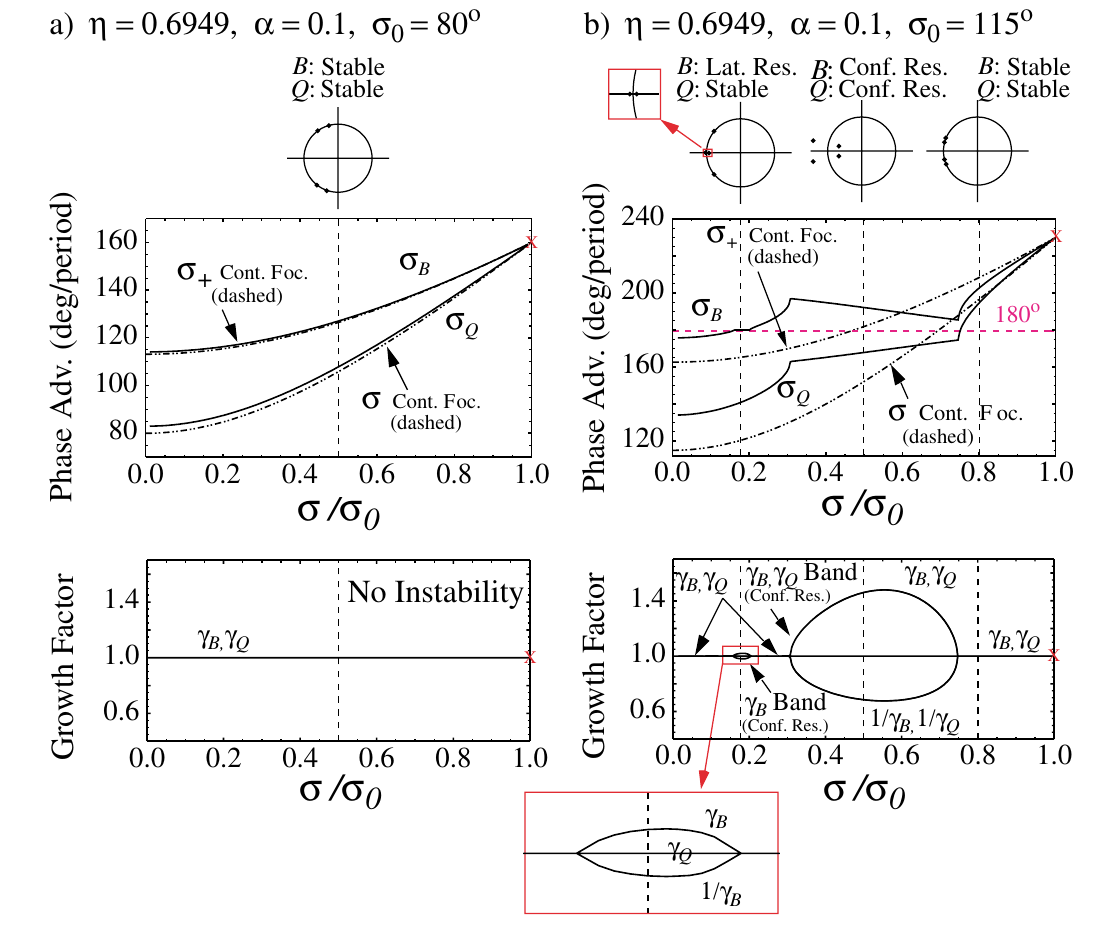
FIG. 17. (Color) Phase advance ( (cid:24) and (cid:24) ) and growth factors ( (cid:6) and (cid:6) ) of the breathing and quadrupole envelope modes B Q B Q for a quadrupole focusing channel with occupancy (cid:31) (cid:1) 0 : 6949 , syncopation factor # (cid:1) 0 : 1 , and (cid:24) versus (cid:24)=(cid:24) 0 115 (cid:31) in (a) and (b). Continuous focusing model predictions for (cid:24) (cid:16) are superimposed on the phase advance plots (dashed curves). Red (cid:22) s mark analytical results in the zero space-charge limit. Vertical dashed lines correspond to locations of plots of complex placed above. Red boxes denote expanded eigenvalues (cid:14) n